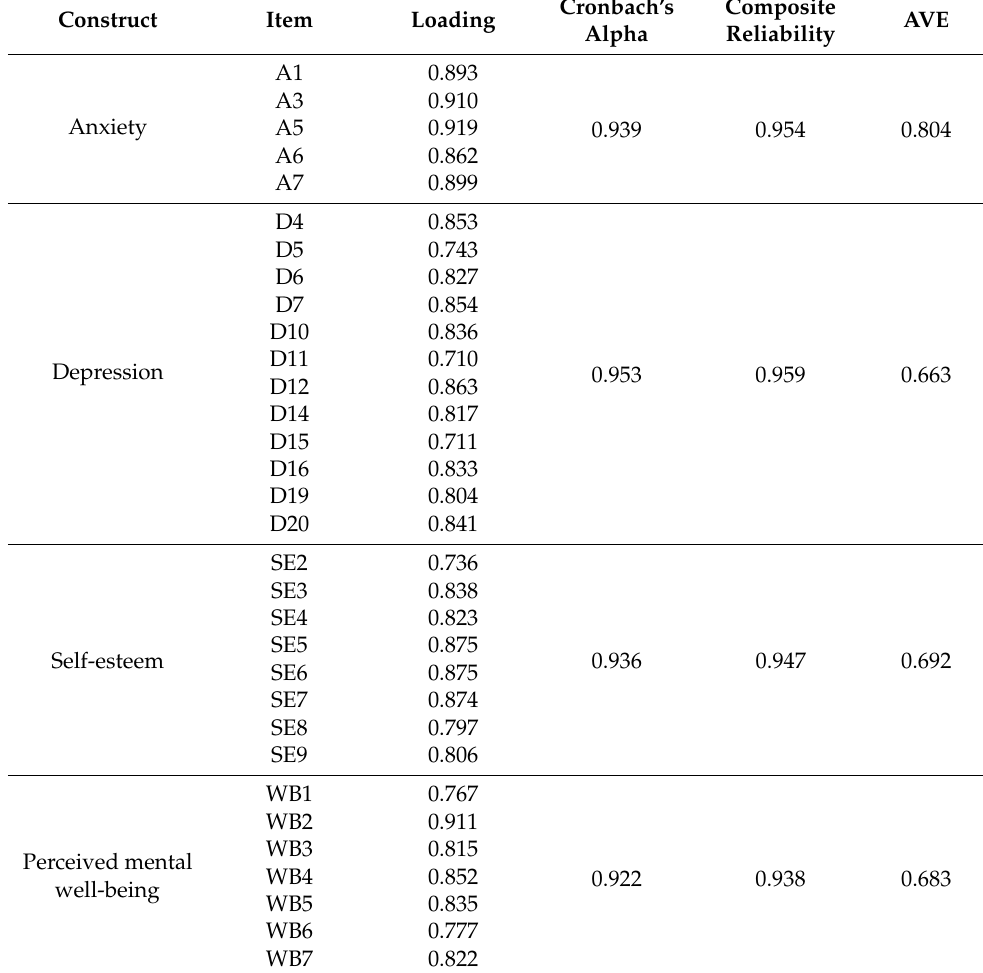
Table 3. Measurement model